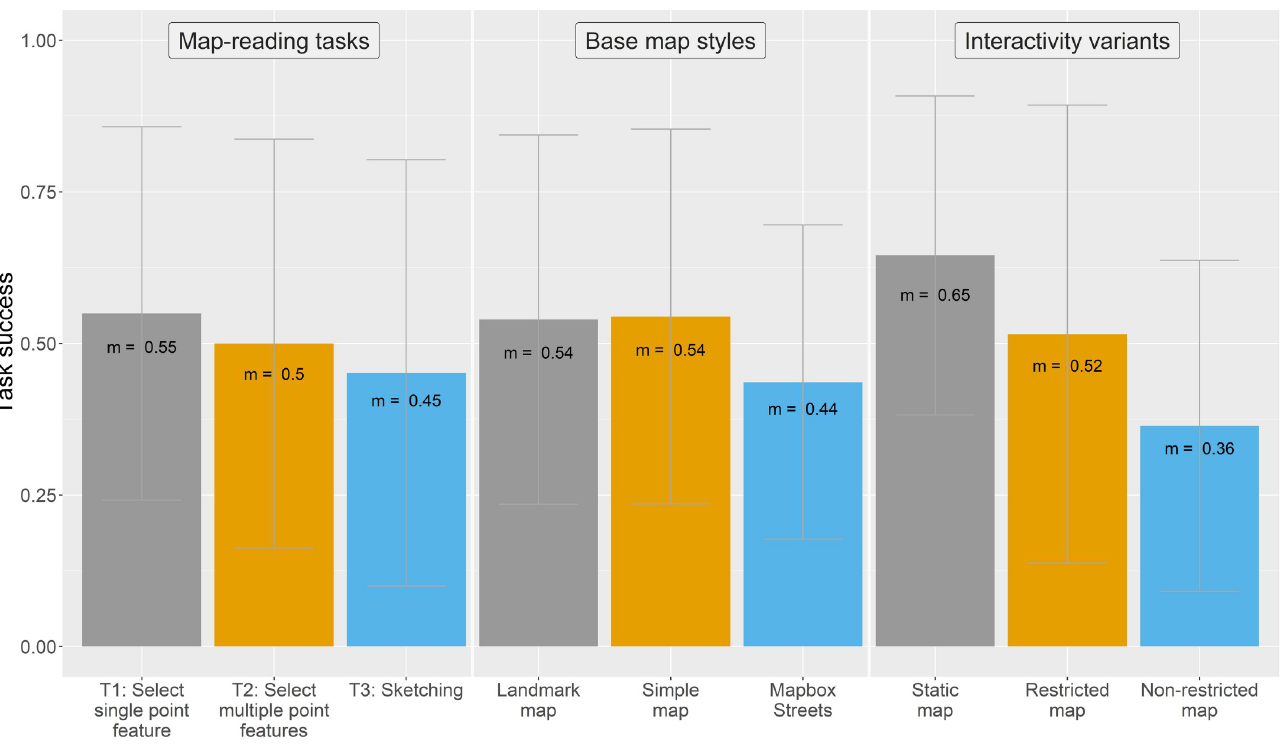
Fig 3. Task success of map-reading tasks, base map styles, and interactivity